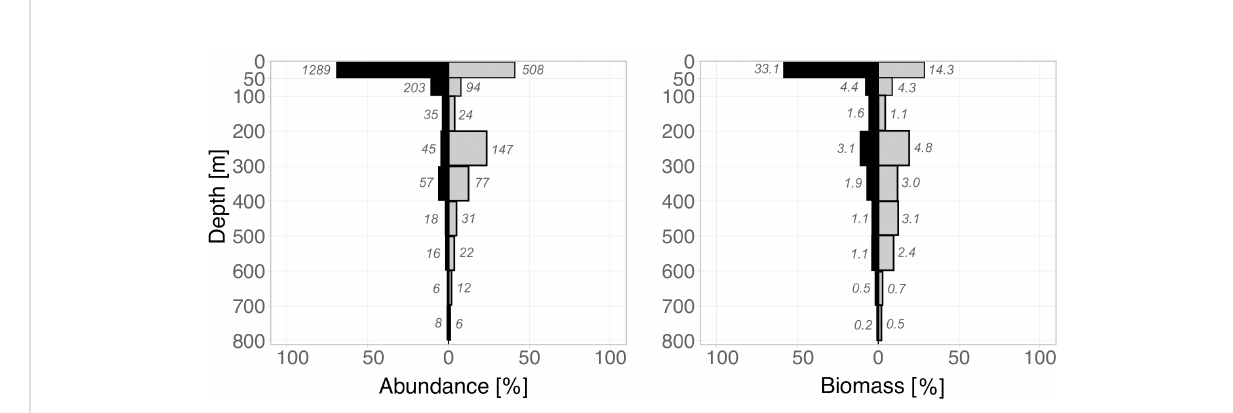
FIGURE 2 Vertical distribution of total calanoid copepod abundance (left) and biomass (right) from the surface to 800 m depth during day (grey bars) and night (black bars). The x-axis depicts the relative total calanoid abundance and respective biomass per station; the numbers beside each bar indicate absolute abundance (ind m -3 ) and biomass (mg DM m -3 ) in that speci fi c depth